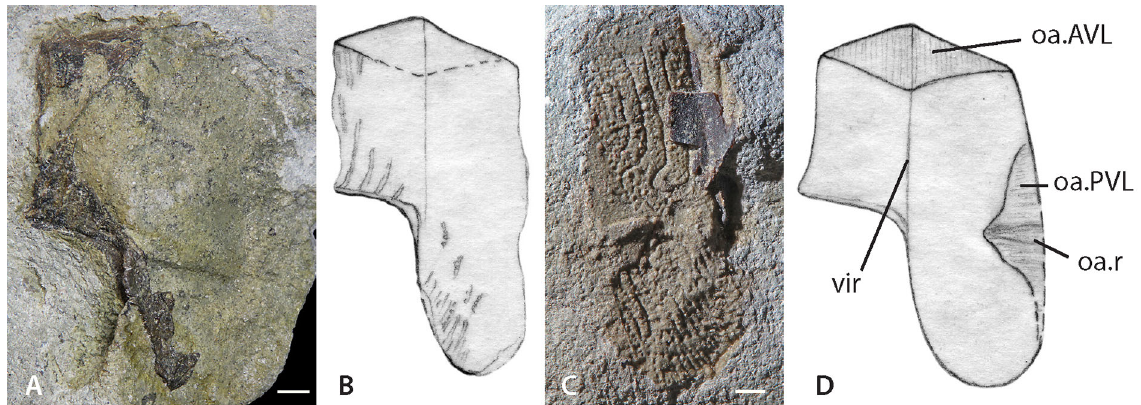
Fig. 9. Microbrachius kedoae from the Gavrilchitsy 45 borehole . Posterior ventro-lateral plates. A , B , GIT 767-1 in ventral view. C , GIT 767-18, in visceral view. D , restoration in ventral view based on A–C. Scale bars = 1 mm. Abbreviations: AVL, anterior ventro-lateral plate; PVL, posterior ventro-lateral plate; oa.AVL, area overlapped by AVL; oa.PVL, area overlapped by PVL; oa.r, overlap ridge; vlr, ventro-lateral ridge of trunk armour.